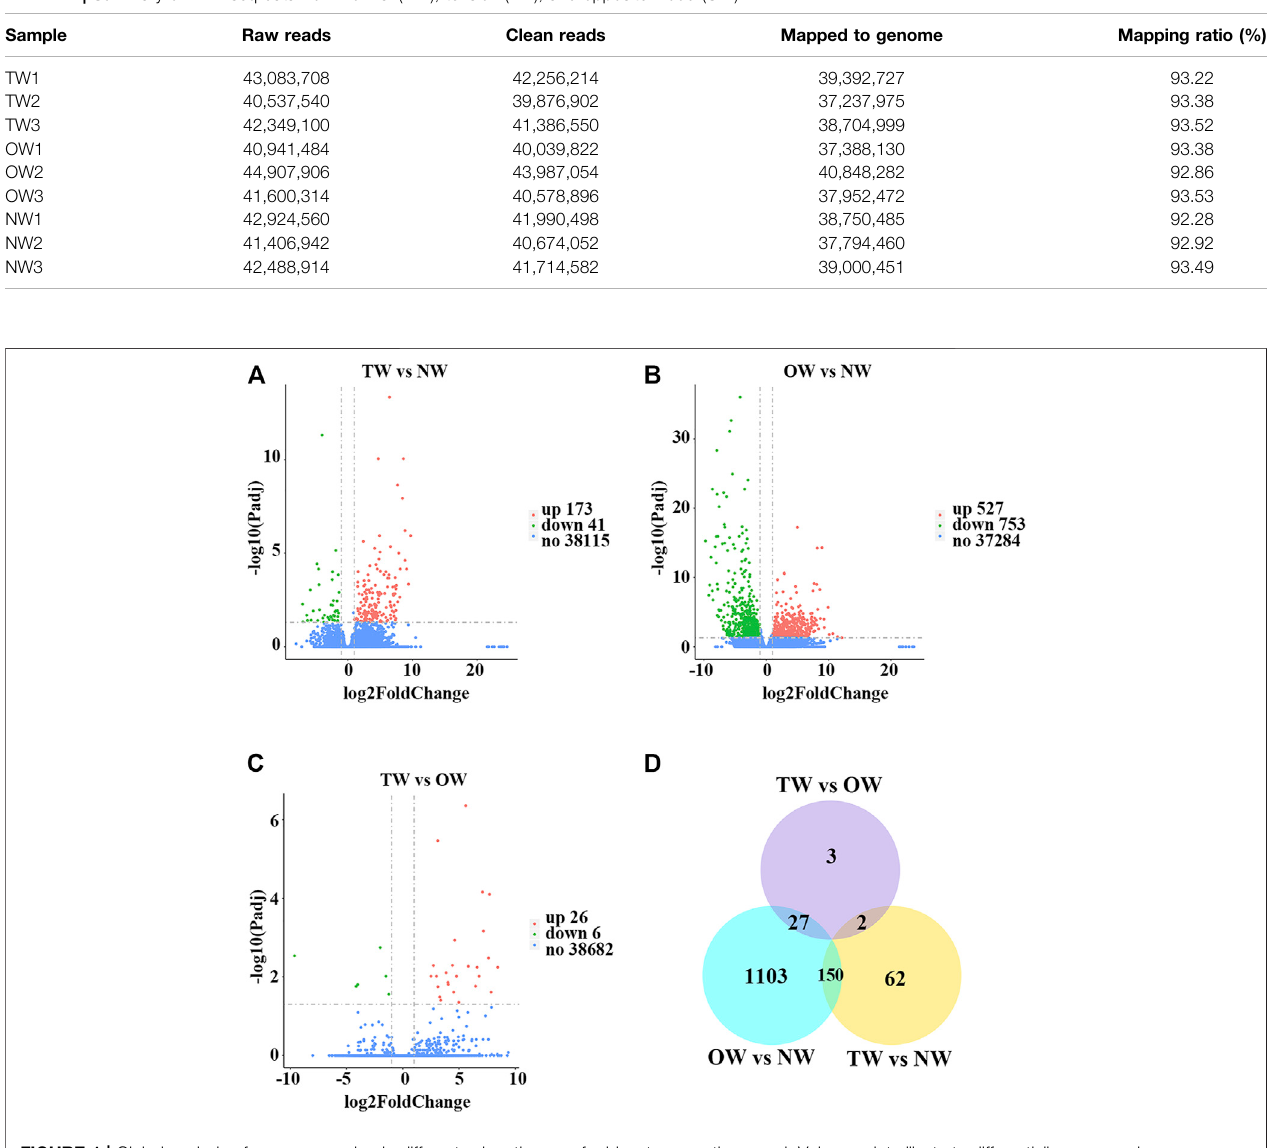
Frontiers in Genetics |